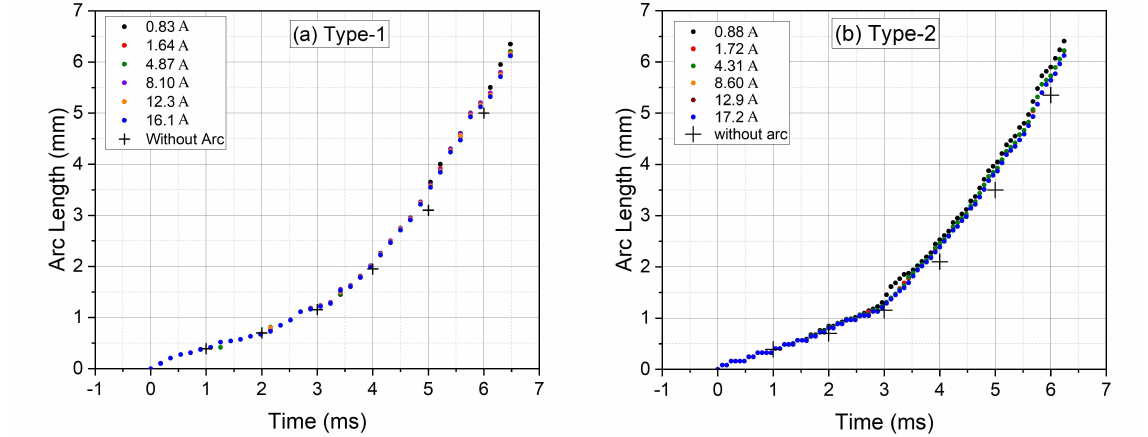
Figure 10. Measured arc length with ( a ) Type-1 contacts; ( b ) Type-2